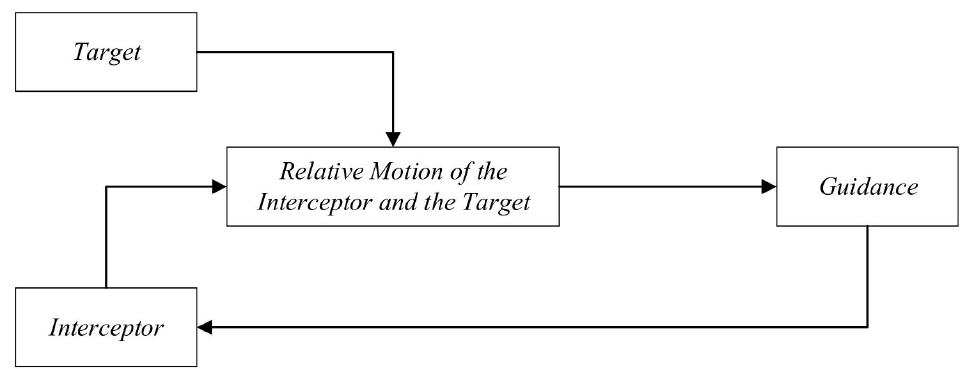
Figure 6. Diagrammatic sketch of side force